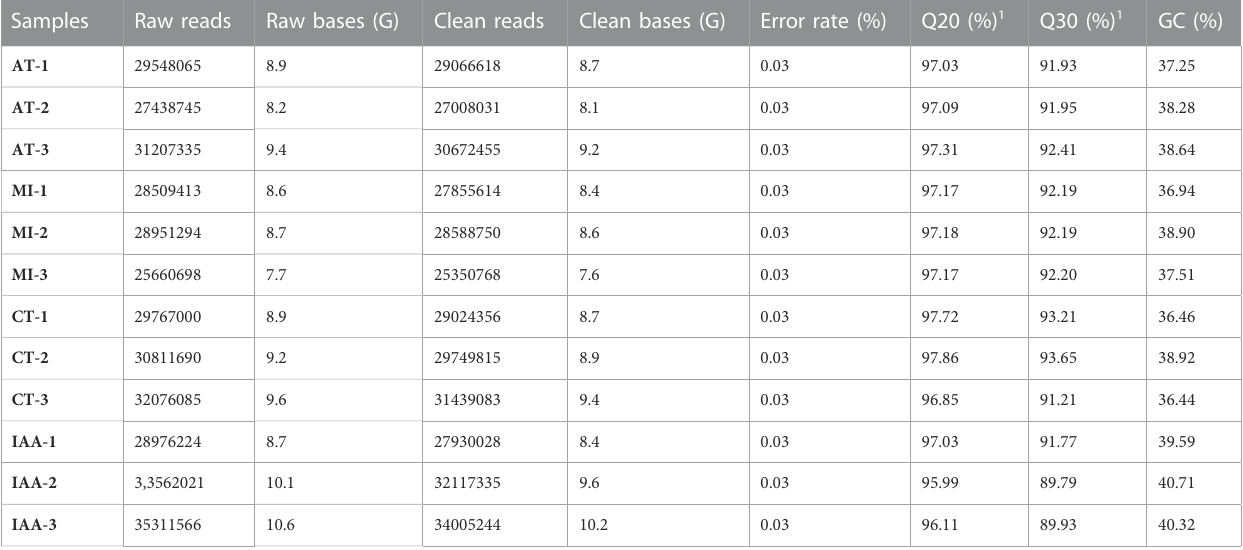
TABLE 1 Summary of de novo assembled transcriptomes.